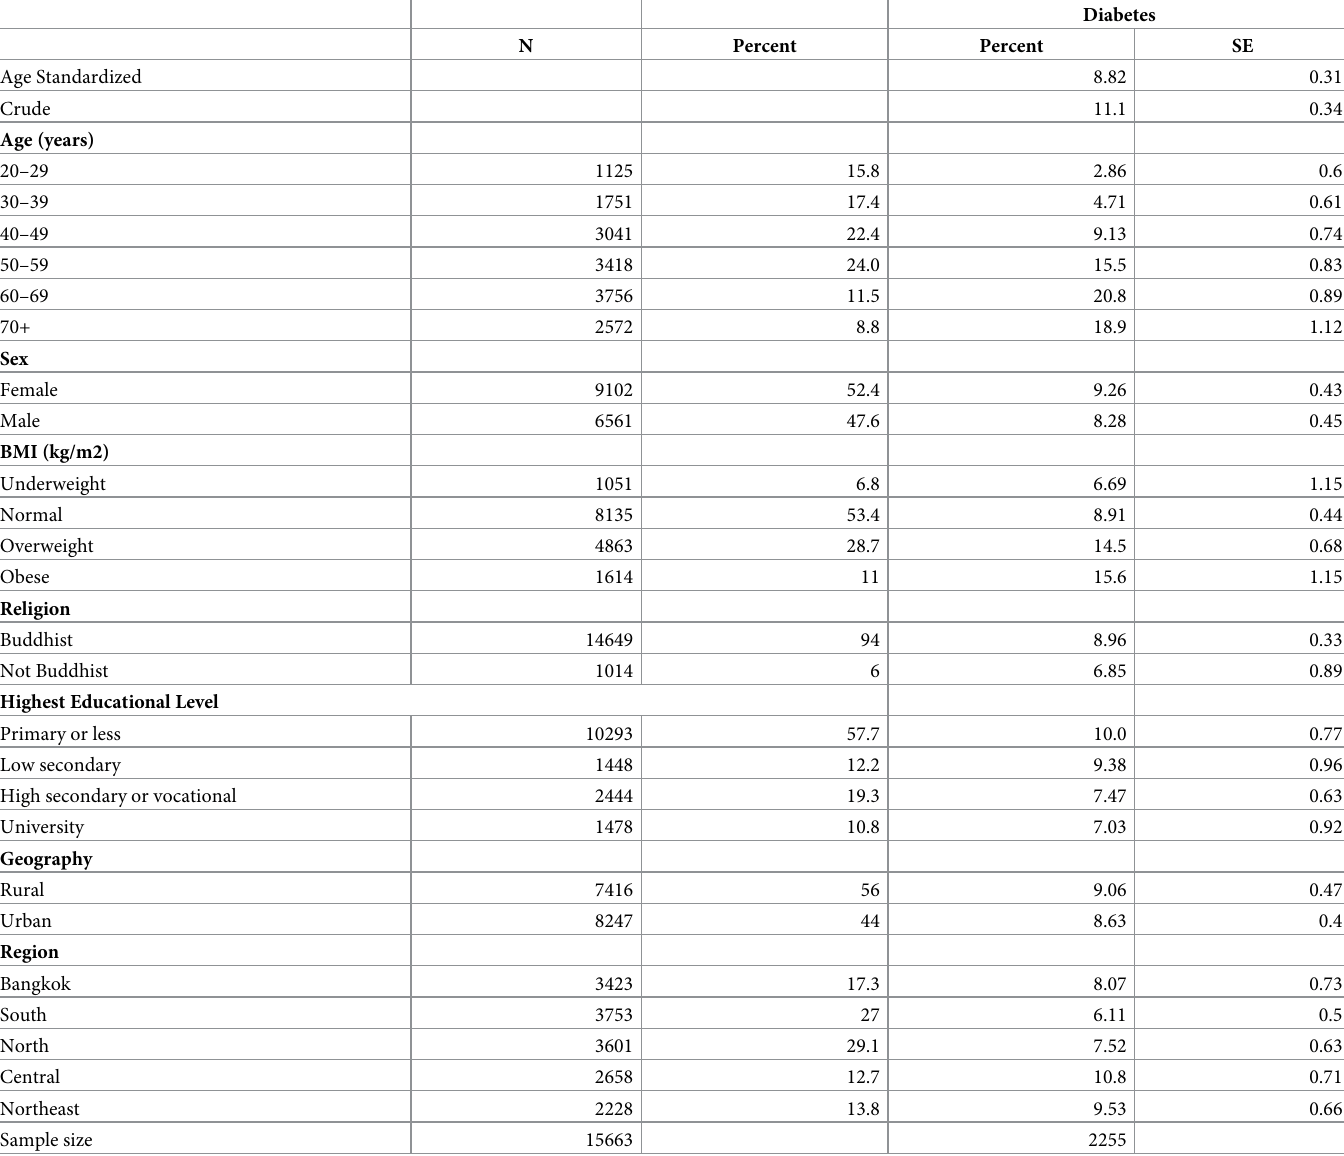
Table 1. Demographic characteristics of analytic sample and prevalence of diabetes, NHES-V Thailand,